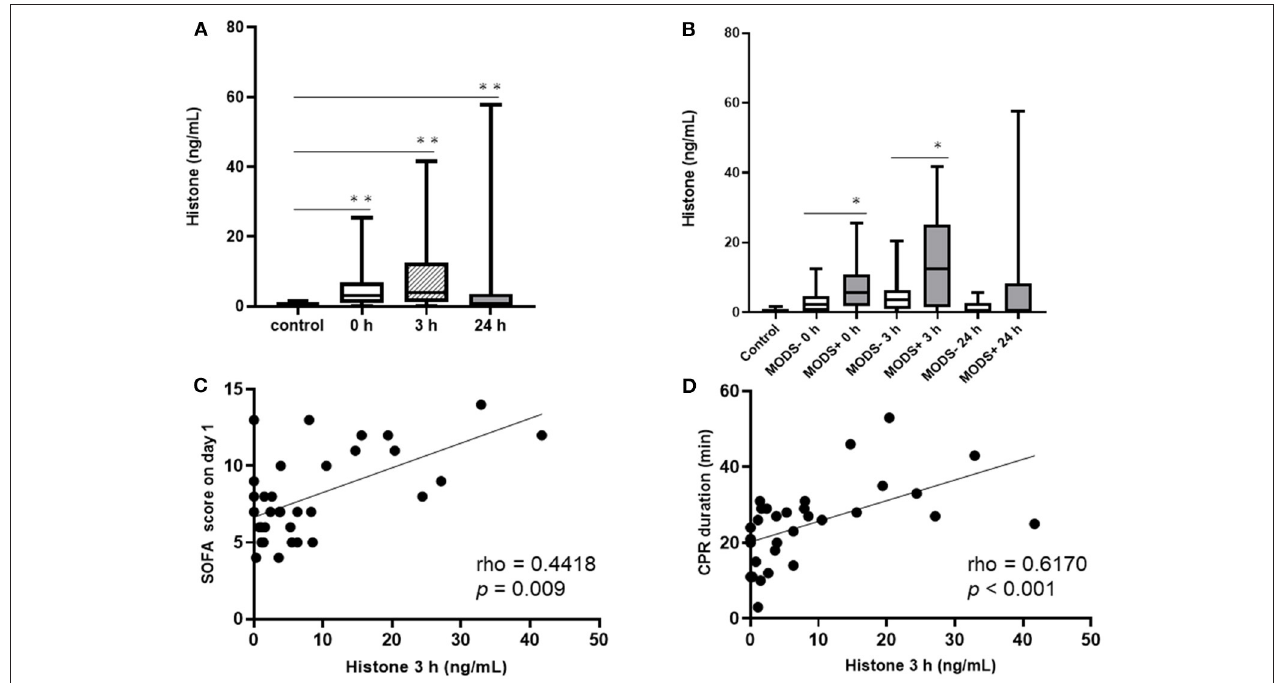
FIGURE 1 | The serial changes of the plasma levels of histones and correlation between the levels of histones at 0h and SOFA score on day 1 and CPR duration. (A) Serial change of the plasma levels of histones. (B) Changes in the plasma levels of histones in the MODS and non-MODS groups. (C) Correlation between the plasma levels of histones at 3h and SOFA score on day 1. (D) Correlation between plasma levels of histones at 3h and CPR duration. * p < 0.05, ** p < 0.001. CPR, cardiopulmonary resuscitation; MODS, multiple organ dysfunction syndrome; SOFA, Sequential Organ Failure Assessment.